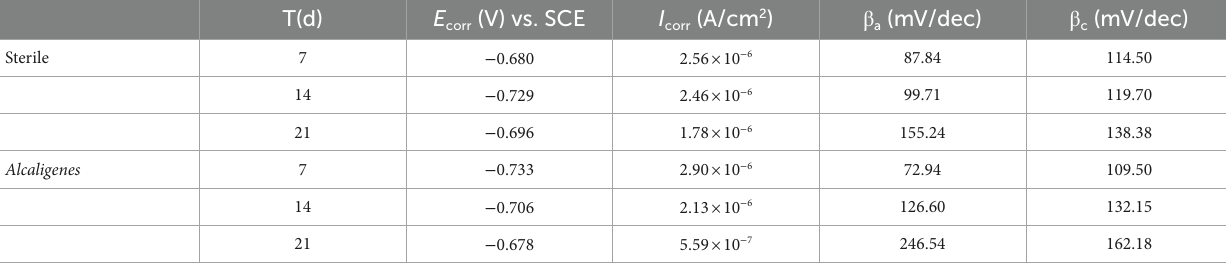
TABLE 2 Fitting parameters of the kinetic potential polarization curves of X65 steel in different media.